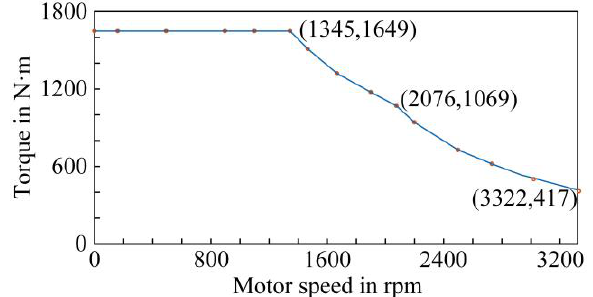
Figure 4. Traction characteristic curve of the urban rail vehicle.